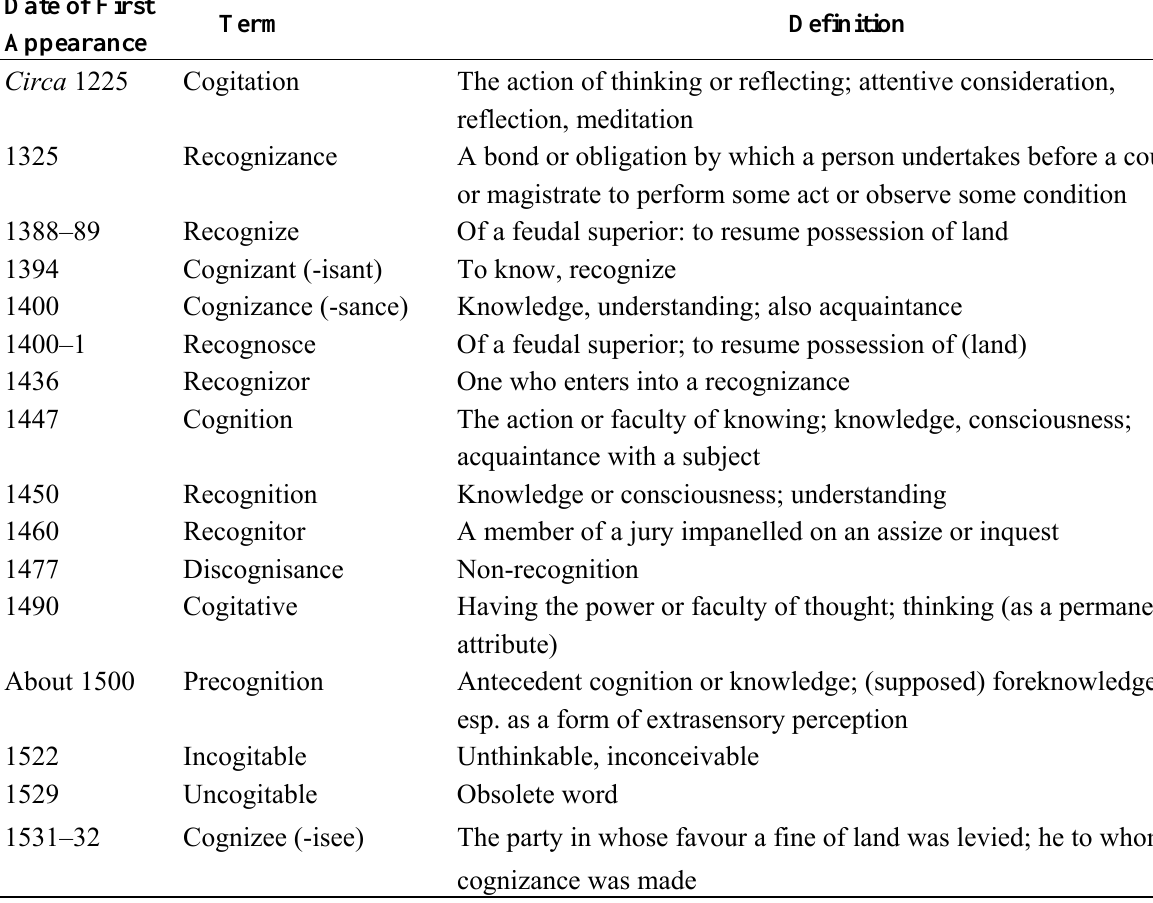
Table 1. Cognition words defined and listed by